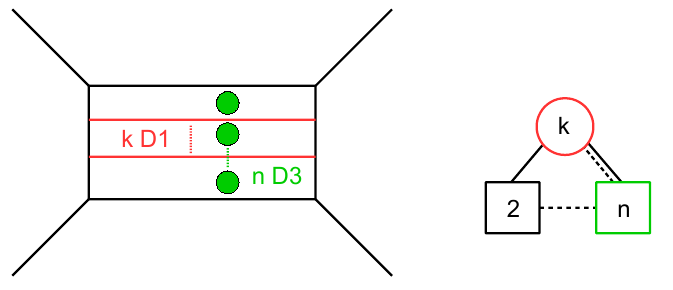
Figure 6 . Brane setup for the k -instanton sector in the presence of the SQM loop and associated N = (0 ; 4) ADHM quiver SQM. The circle denotes a U( k ) vector multiplet with an adjoint hyper- multiplet, the continuous line a bifundamental hypermultiplet, the dashed line a Fermi multiplet with single fermion and the mixed-doubled line a twisted hypermultiplet and a Fermi multiplet with two fermions. The SU(2) (cid:13)avor symmetry is gauged with 5d (cid:12)elds in the 5d-1d theory. (continuous line), n fundamental twisted hypermultiplets and n Fermi multiplets with two complex fermions (doubled continuous-dashed lines), and 2 n uncharged Fermi multiplets with a single fermion (dashed line). In addition there are potential terms (J and E terms) required by (0,4) supersymmetry and other potentials coupling 1d and 5d (cid:12)elds. 15